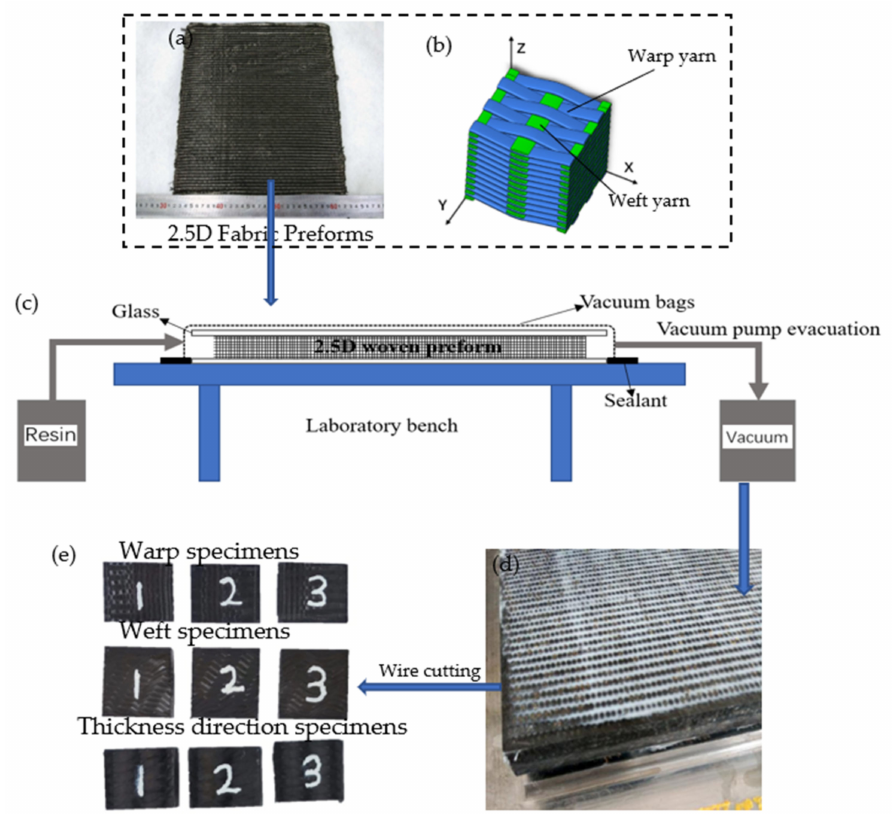
Figure 1. Preparation of 2.5D specimen ( a ) 2.5D woven prefabricated parts; ( b ) schematic diagram of the model; ( c ) schematic diagram of the VARTM; ( d ) 2.5D woven composite sample; ( e ) compres- sion